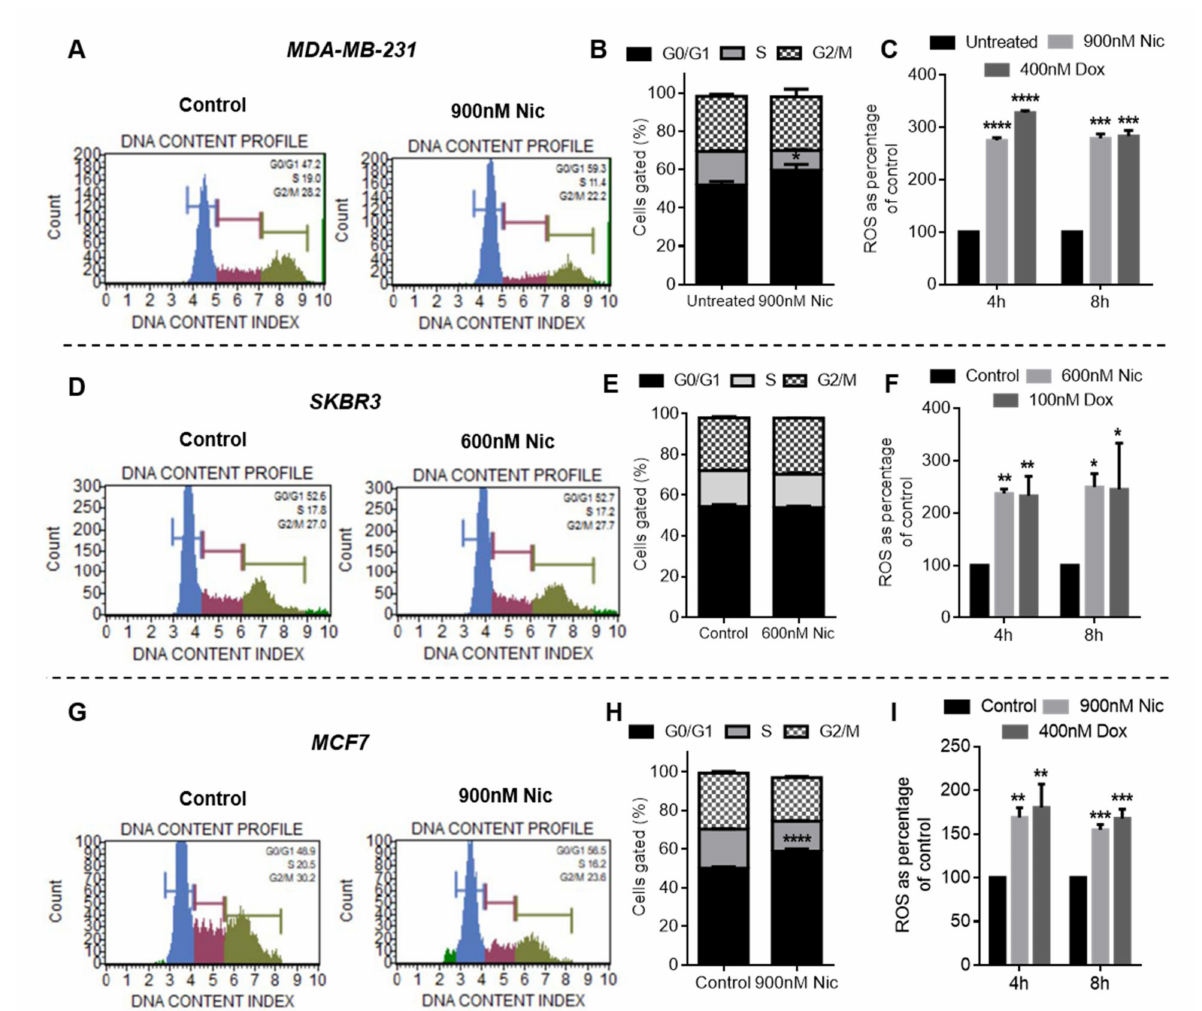
Figure 4. Cell cycle and ROS analysis in breast cancer cells. Cell cycle histograms of ( A ) MDA-MB-231, ( D ) SKBR3, and ( G ) MCF7 cells, when treated with selected concentrations of Nic for 24 h. Blue color indicates cells in G0/G1 phase, magenta color indicates cells in S phase, and green color indicates cells in G2/M phase. Quantitative representation of cell cycle histograms shown in ( A , D , G ) for ( B ) MDA-MB-231, ( E ) SKBR3, and ( H ) MCF7 cells. * ( p < 0.05) and **** ( p < 0.0001) indicate statistically significant increase in G0/G1 phase of the Nic-treated group with respect to the untreated group (n = 3). Reactive oxygen species (ROS) analysis of Nic- and Dox-treated cells at indicated doses for 4 h and 8 h through DCFDA assay in ( C ) MDA-MB-231, ( F ) SKBR3, and ( I ) MCF7 cells. * ( p < 0.05); ** ( p < 0.01), *** ( p < 0.001), and **** ( p < 0.0001) indicate statistically significant difference with respect to the untreated group ( n =